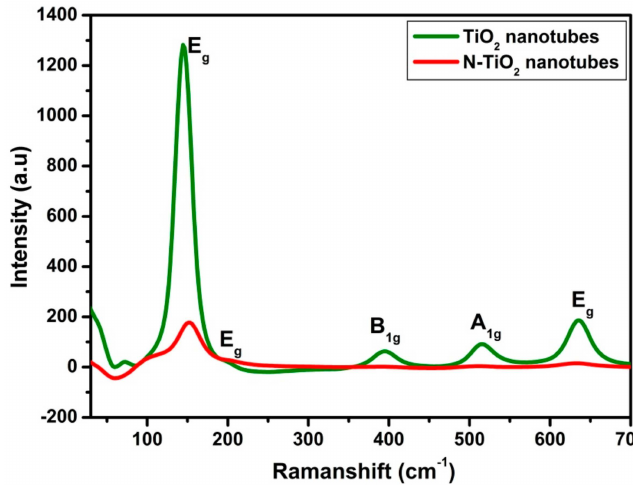
Figure 2. Raman spectra of TiO 2 nanotubes and N-TiO 2